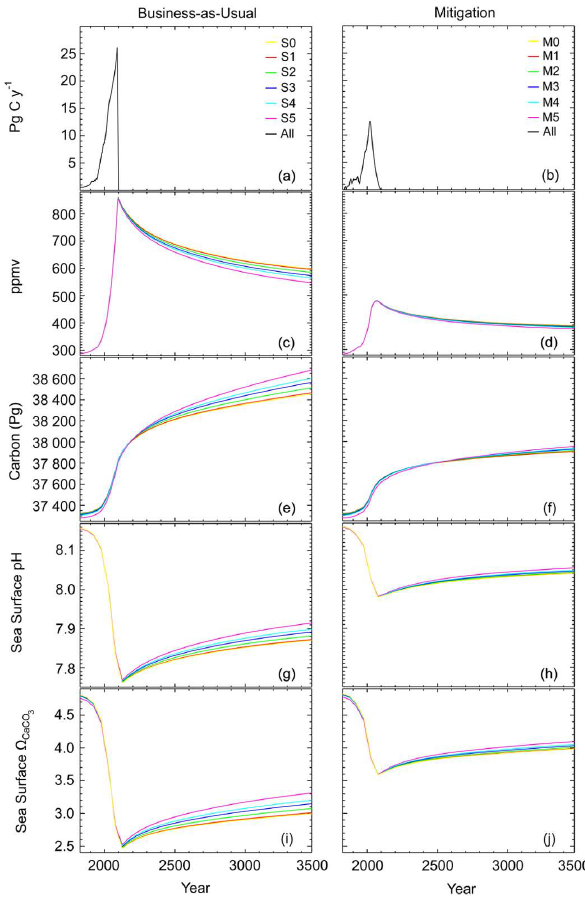
Fig. 5. (a, b) Change in anthropogenic CO 2 emissions, (c, d) glob- ally averaged atmospheric CO 2 concentration, (e, f) globally aver- aged ocean carbon, (g, h) globally averaged sea surface pH, and (i, j) globally averaged calcite saturation state under a “business-as- usual” (Suite S) and a “mitigation” CO 2 emissions scenario (Suite M)